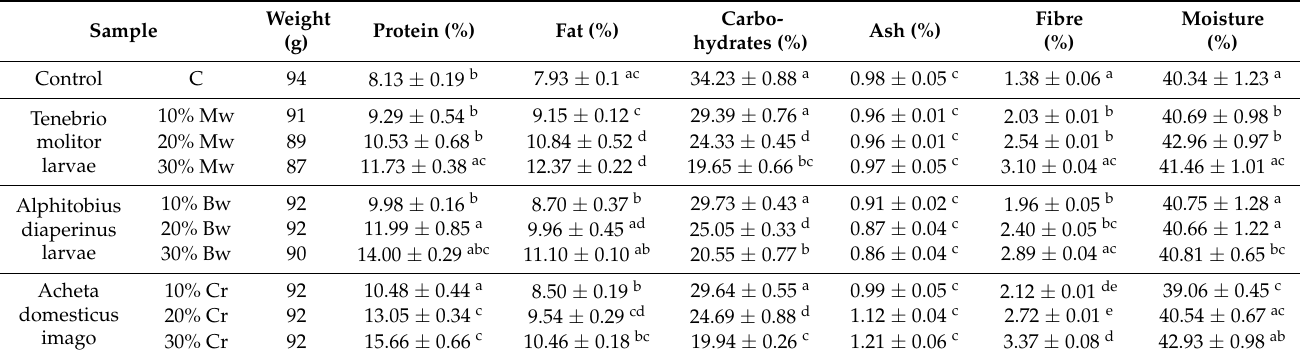
Table 2. Nutritional value of a pancake portion (240